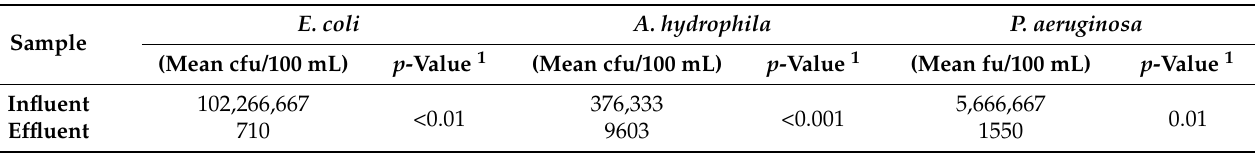
Table 1. Bacterial counts in influent and effluent samples from the Legon Sewage Treatment plant, Accra, Ghana (January to June 2018).